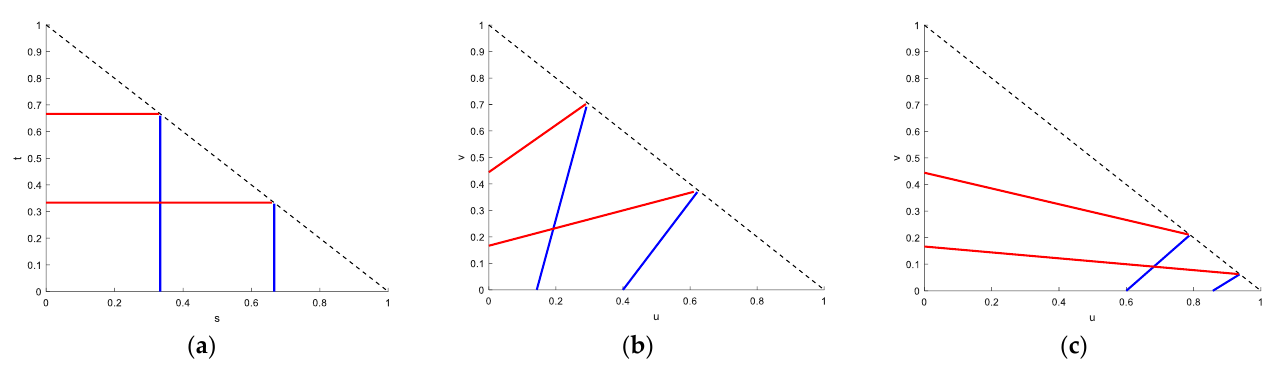
Figure 2. Both the ( u , v ) curves in the definition domain variety when we change the value of α only. ( a ) Uniform distribution of ( s , t ) curves. ( b ) ( u , v ) curves for α = 1/3, β = 0.4. ( c ) ( u , v ) curves for α = 3, β = 0.4.